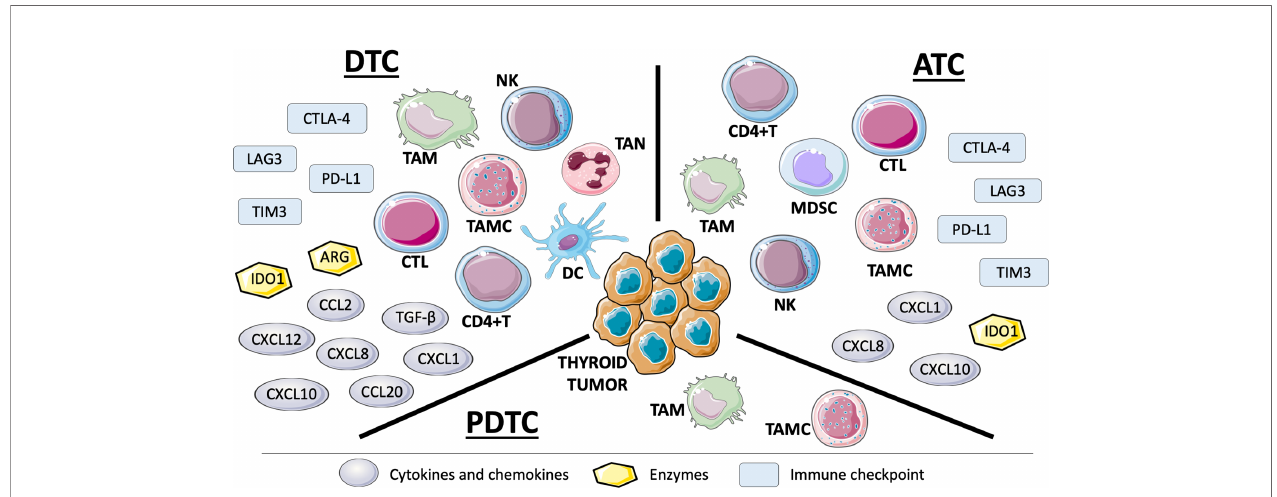
FIGURE 1 | Representation of immune cells, solule mediators, and negative immune checkpoints in tumor microenvironment (TME) of thyroid tumor histotypes based on the studies carried out so far. TME of DTCs is the most frequently studied also because they are the most common thyroid carcinomas. ATCs have been shown to be richly in fi ltrated by cells and mediators of immune system. The few works on PDTCs display TAMs and TAMCs in their TME (see text for details).: DTC, differentiated thyroid cancer; ATC, anaplastic thyroid cancer; PDTC, poorly differentiated thyroid cancer; NK, natural killer; TAM, tumor-associated macrophage; TAN, tumor-associated neutrophil; TAMC, tumor-associated mast cell; CTL, cytotoxic T lymphocyte; DC, dendritic cell; CD4+T, CD4+ T helper cell; MDSC, myeloid- derived suppressor cell; CXCL, C-X-C motif chemokine ligand; CCL, C-C motif chemokine ligand; TGF- b , transforming growth factor- b ; IDO1, indoleamine 2,3- dioxygenase 1; ARG, arginase; CTLA-4, cytotoxic T-lymphocyte associated protein 4; TIM3, T cell immunoglobulin and mucin domain 3; LAG3, lymphocyte activation gene 3; PD-L1, programmed cell death ligand